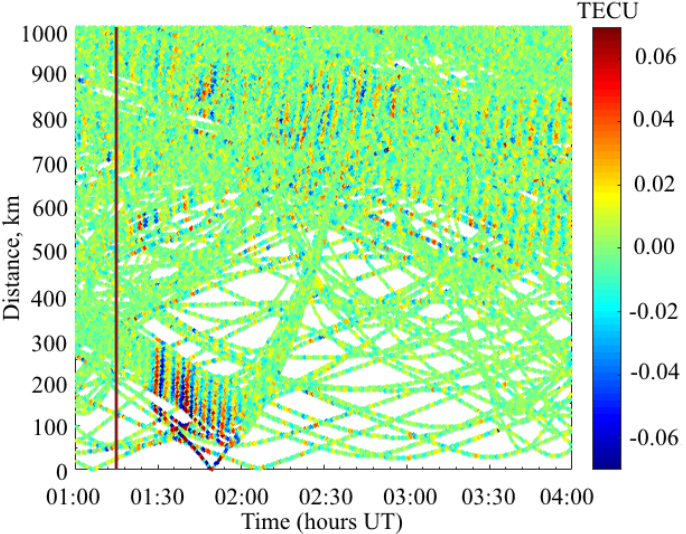
Figure 8. The traveltime diagram plotted by using all visible satellites between 01:00–04:00 UT on 15 June 2009. The vertical red solid line indicates the explosion time. Color represents the appropriate TEC amplitude.